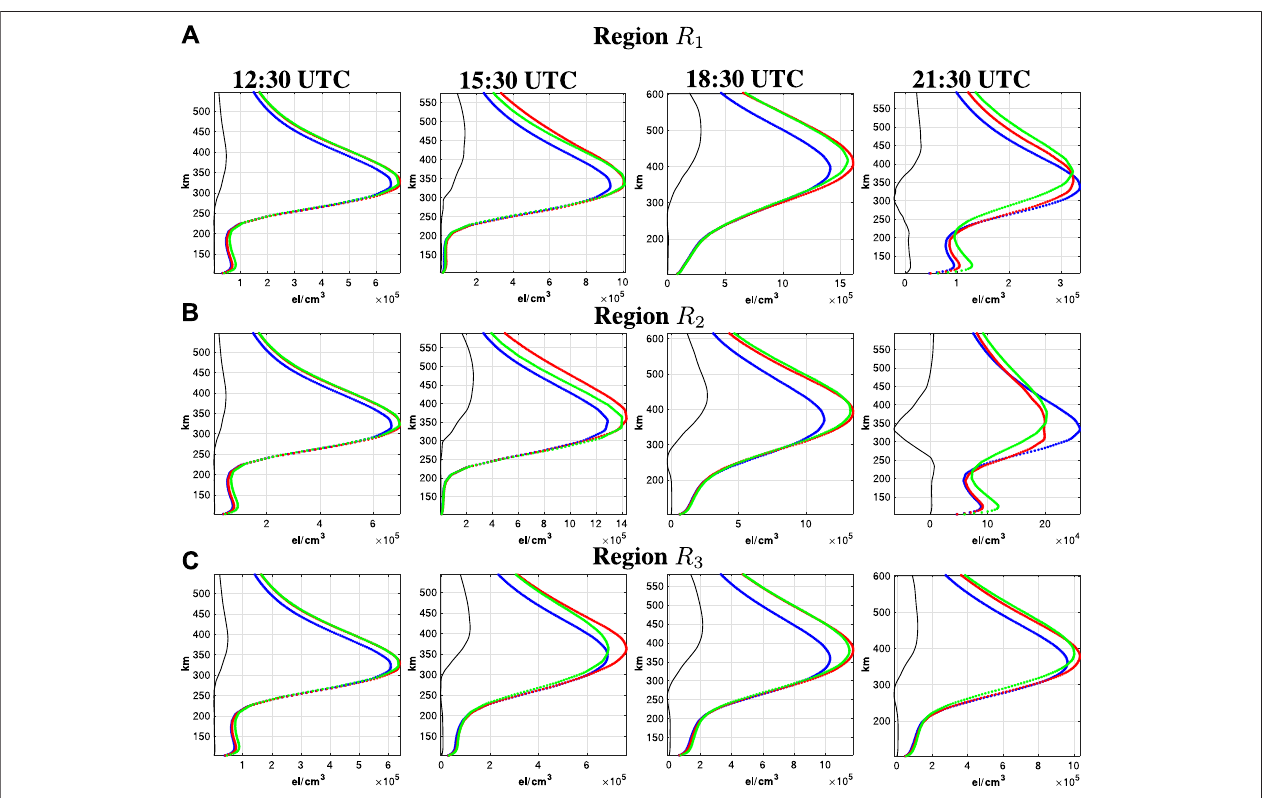
FIGURE 8 | (A) Comparison of 1 h electron density vertical pro fi le predictions at the indicated times on September 26, 2011. The green pro fi le in each fi gure is the average of all COSMIC electron density vertical pro fi les located in region R 1 (as de fi ned in Figure 2A ). The forecasted electron density is also shown before (blue) and after (red) the bias correction, shown by the black curve, is applied. (B,C) Analogous comparison of electron density predictions over regions R 2 and R 3 at the same times. In all fi gures, the vertical axis is altitude in km and the horizontal axis is electron density in el / cm 3